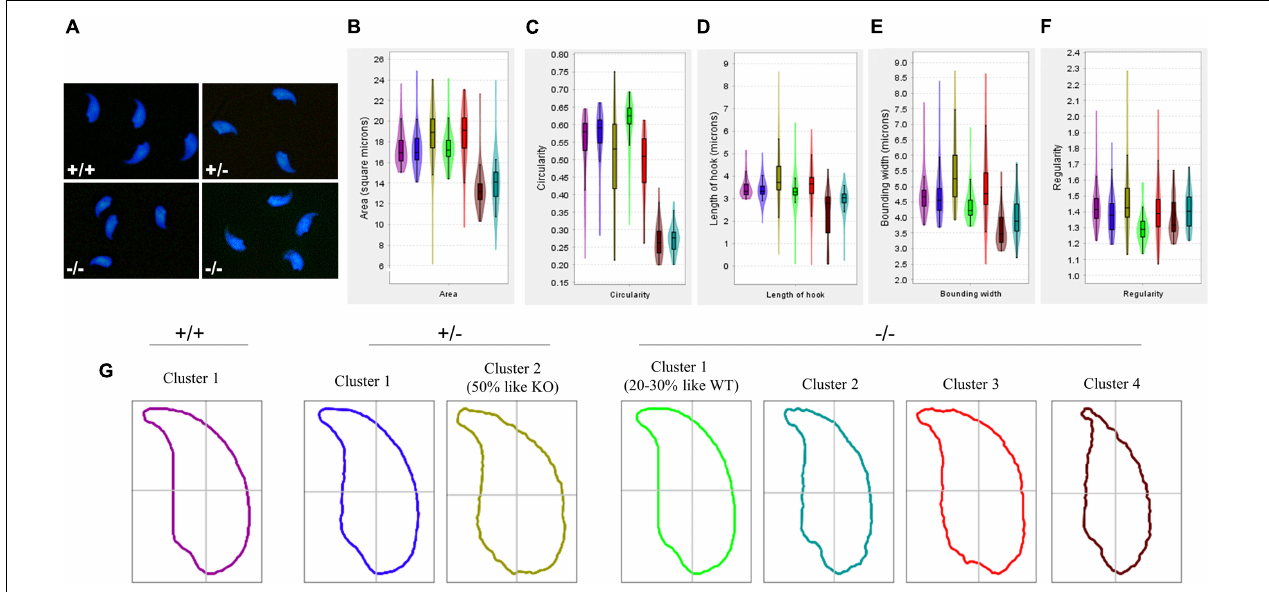
FIGURE 3 | Amorphous nuclear morphology of sperm cells in Pfn3 -deficient mice. (A) Sperm cells stained with DAPI. (B) Area, (C) circularity, (D) length of hook, (E) bounding width, and (F) regularity of Pfn3 + / + , Pfn3 + / − , and Pfn3 − / − sperm cells. (G) Head shape of Pfn3 + / + sperm cells, two clusters for Pfn3 + / − sperm cells, and four clusters for Pfn3 − / − sperm cells. TABLE 1 | Motility parameters were analyzed for Pfn3 + / + , Pfn3 + / − , and Pfn3 − / − sperms using OpenCASA software ( n = 3/genotype). VSL mean ( µ m/s) VCL mean ( µ m/s) VAP mean ( µ m/s) Progressive motility (%) Motility (%) Pfn3 + / + 62 . 33 ± 1 .